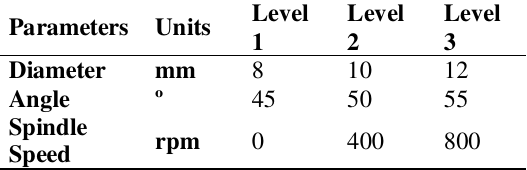
Forming parameters and their levels for ball end and hemispherical tools Parameters